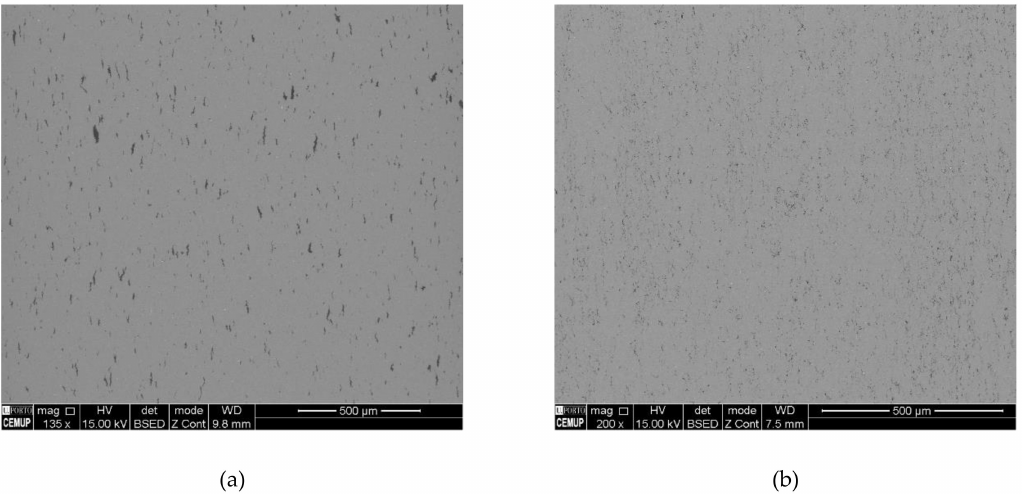
Figure 5. SEM/BSE image from 0.75 wt. % MWCNT composite after ( a ) normal sonication method, as described in No. 2 in Table 3; and ( b ) assisted sonication method, as seen in No. 4 in Table